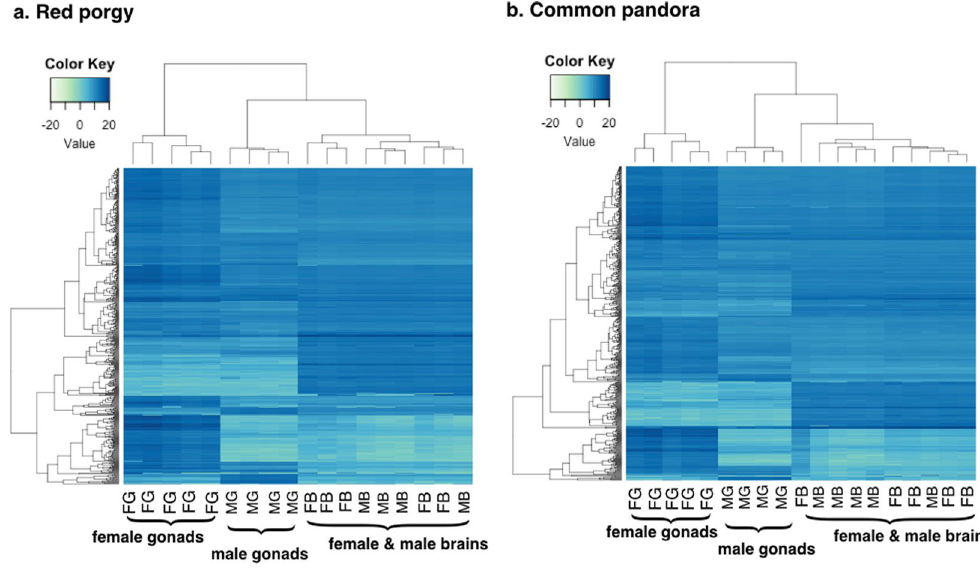
Figure 4. Heatmap plots for global expression profiles in two protogynous sparids. Heatmaps of the variance stabilized, transformed count data for male and female brains and gonads. ( a ) Red porgy, ( b ) Common pandora samples clustered according to their global gene expression patterns. Only the top 500 variable genes were used to produce the heatmaps for visibility reasons.